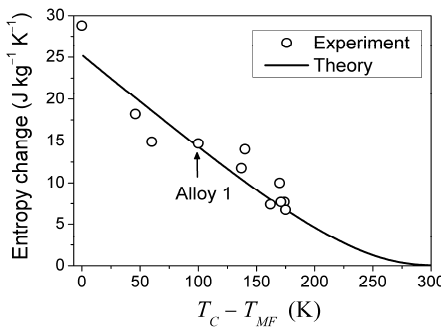
Figure 13. Theoretical values of magnetic entropy change (line) and experimental values of total entropy change (circles) at MTs in the Ni-Mn-Ga